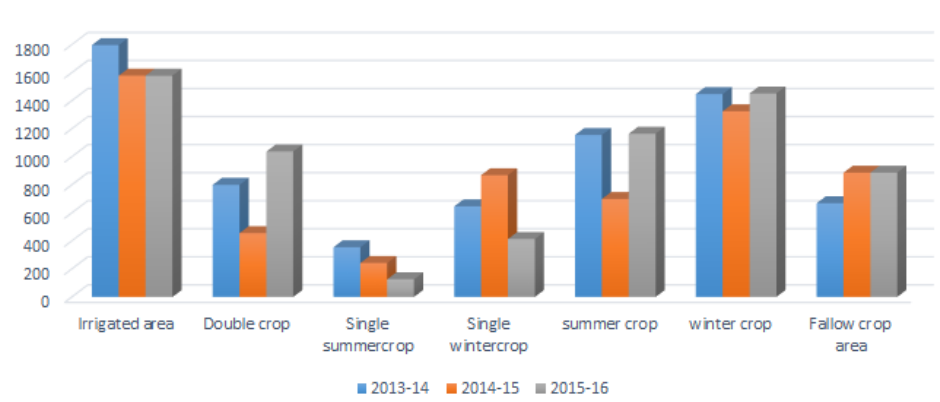
Figure 9. Bar graph showing annual surface area of fallow, irrigated and five irrigated land use types. Note that the classes “summer crop” and “winter crop” include “double crop”